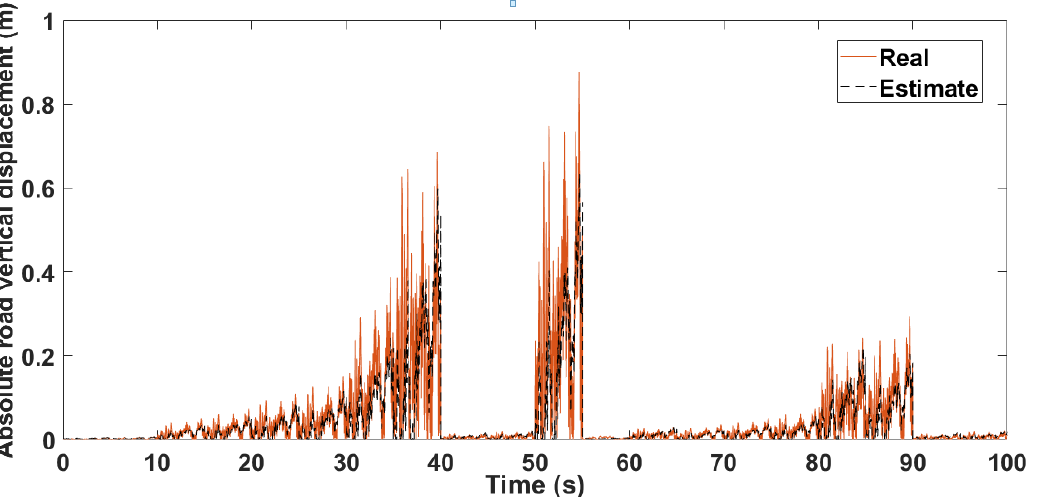
Figure 8. Absolute vertical road displacement